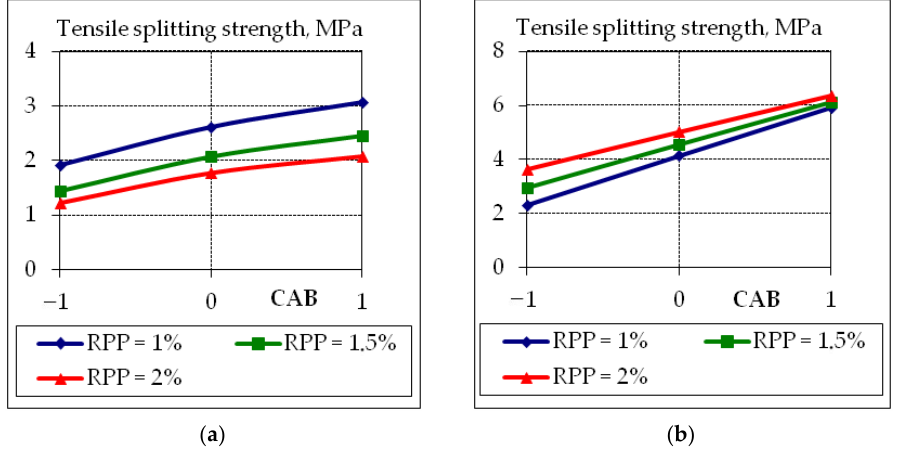
Figure 8. Graphical dependences of tensile splitting strength at the age of 1 day ( a ) and 28 days ( b ) of fly ash concrete suitable for 3D printer, where the content of CAB −1 = 15%; 0 = 17.5%; +1 = 20%. The obtained results clearly show the negative effect on the tensile splitting strength (Figure 8a) and compressive strength (Figure 9a) of concrete at the age of 1 day with the increasing of the content of the RPP additive (down to 50%). However, it should be noted that with increasing polymer content, there is a positive effect on the tensile splitting strength at the age of 28 days (Figure 8b) increase by 8–12% (from 2.2 MPa to 3.8 MPa) and 35–40% (from 5.95 MPa to 6.5 MPa) at CAB consumption 20% and 15%, respectively. Polymers reduce the rate of hydration at an early age; thus, reducing the amount of calcium hydroxide that binds to fly ash, forming additional neoplasms that affect the properties of mixtures suitable for 3D printers; these statements are confirmed in [22–25].